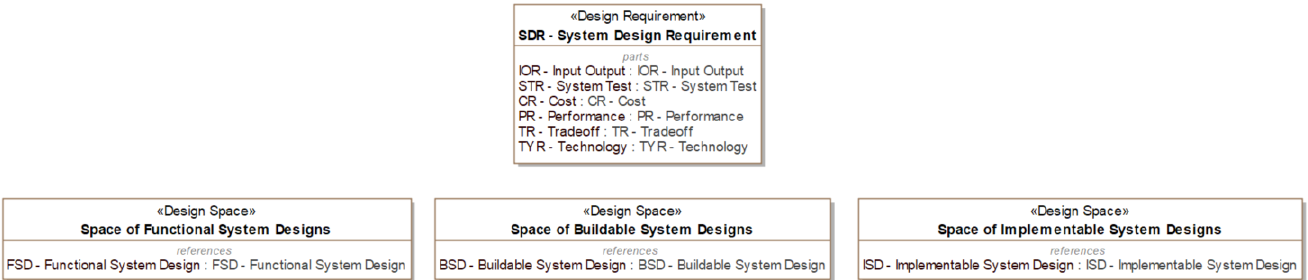
Figure 4. A subset of the metamodel that includes the foundational elements: System Design Requirement, Space of Functional System Designs, Space of Buildable System Designs, and Space of Implementable System Designs. These are discussed in detail in the following sections.